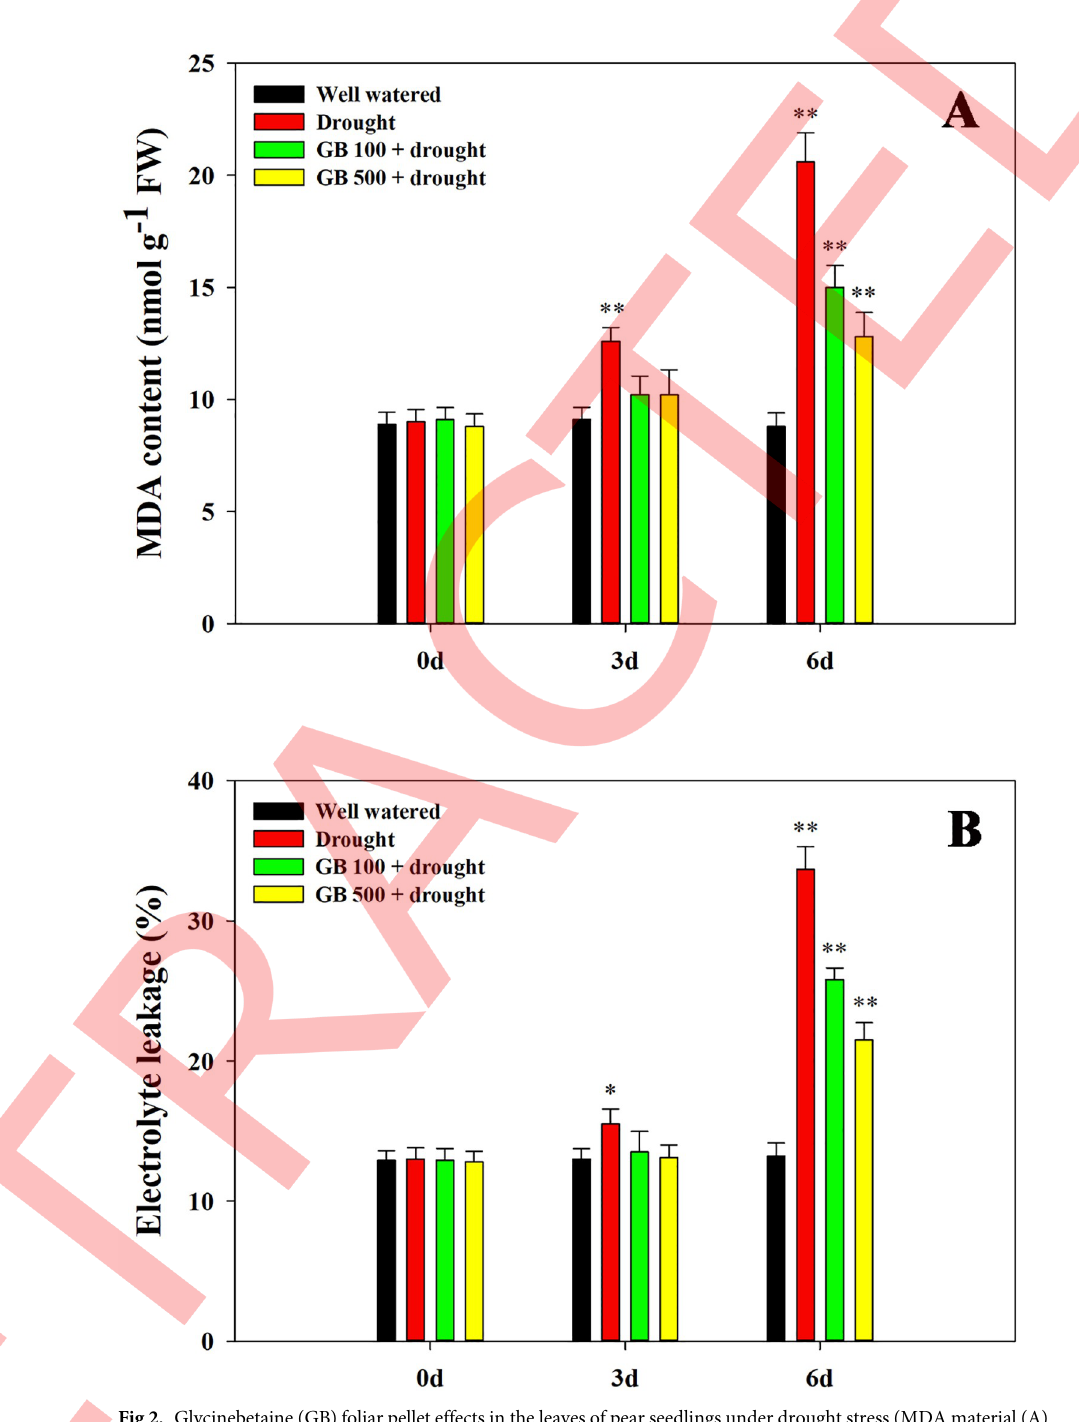
Fig 2. Glycinebetaine (GB) foliar pellet effects in the leaves of pear seedlings under drought stress (MDA material (A) and electrolyte leakage (B)). The foliage was sprayed on the pear plants with GB solution of 0 (Drought), 100 (GB 100 + drought) or 500 mg L − 1 (GB 500 + drought). Well-watered plants with the same amount of water were also sprayed. Depending on the content of soil water and the water capacity, on the third and sixth days after foliar spraying (or withholding of the water), both the "Drought" and "GB + dryness" classes exhibited mild and severe drought stress characteristics. Important discrepancies are shown between asterisks and well-watered plants ( � P < 0.05, �� P < 0.01, Student 0 s t -test). Six replicates of the data are shown as the mean ±